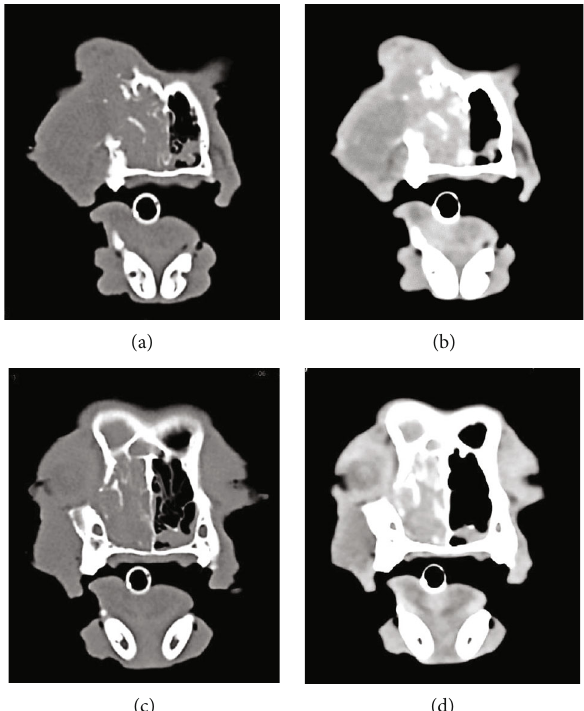
Figure 6: The CT images depict soft tissue (b, d) and bone window (a, c) images of the rostral (a, b) and caudal (c, d) portions of a large facial carcinoma that involved the right orbital wall and nasal turbinate bones and had extended into the paranasal sinuses.